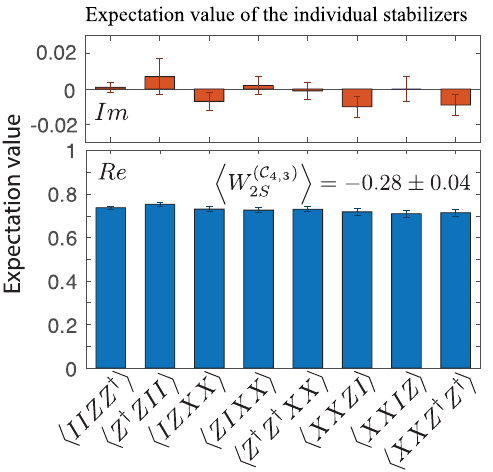
Figure 6: Measurement of the entanglement witness. Real and imaginary (blue and red bars, respectively) parts of the measured expectation values for the individual terms comprising the witness operator. Since only the eight real parts contribute to the expectation value of the witness, this results in a real number that, being negative, confirms the genuine four-partite three-level entanglement of the generated cluster state. Adapted from